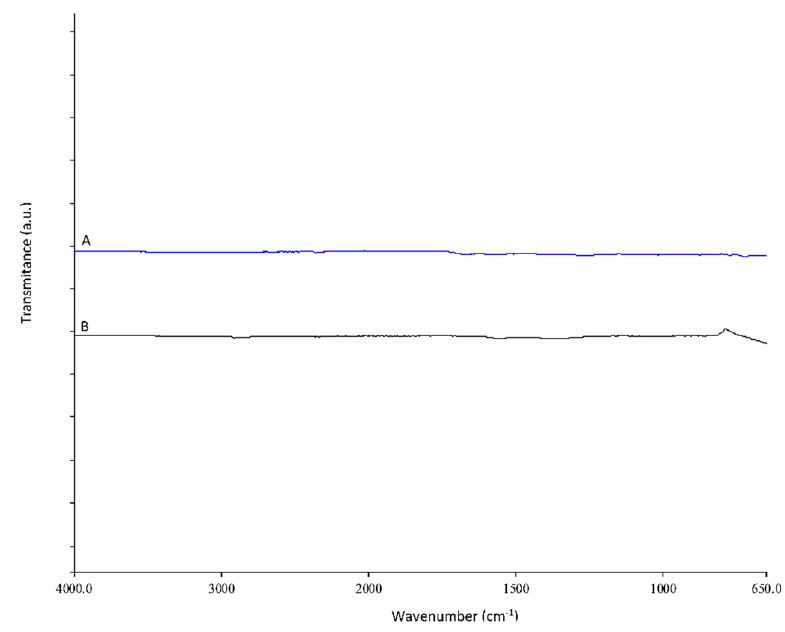
Figure 10. ATR–FTIR spectra of impurities obtain after purification step from neutral hydrolysis (A-blue spectrum) and after alkaline hydrolysis (B-back spectrum).